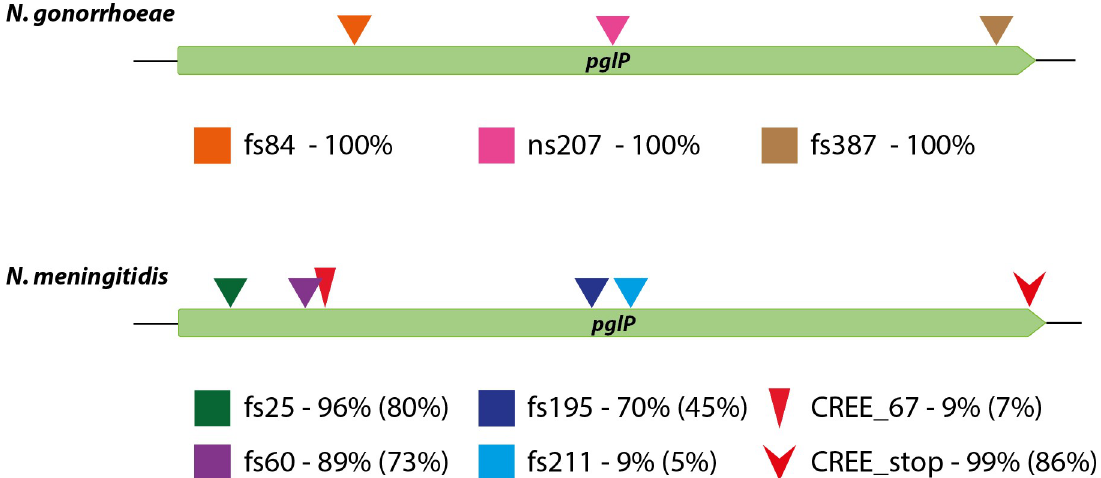
Fig 6. Pseudogenization of the pglP glycosyltransferase gene. Positions of ORF-disrupting SNVs in N . gonorrhoeae (top) and of ORF- disrupting SNVs and CREE insertions in N . meningitidis (bottom). For N . gonorrhoeae , the results include those from S1 Dataset as well an additional 833 genomes from gonococcal isolates of diverse geographic and temporal origins (S2 Dataset). For N . meningitidis , the percentage strains carrying particular disruptions are from strains in the 107 isolate strain collection representing global diversity in the latter half of the 20th century (Neisseria PubMLST database) followed in parentheses by those in 3567 isolates in the Meningitis Research Foundation Meningococcus Genome Library. Reductions in the percentage of ORF-disrupting mutations in the latter collection are associated with an over-representation of CC269